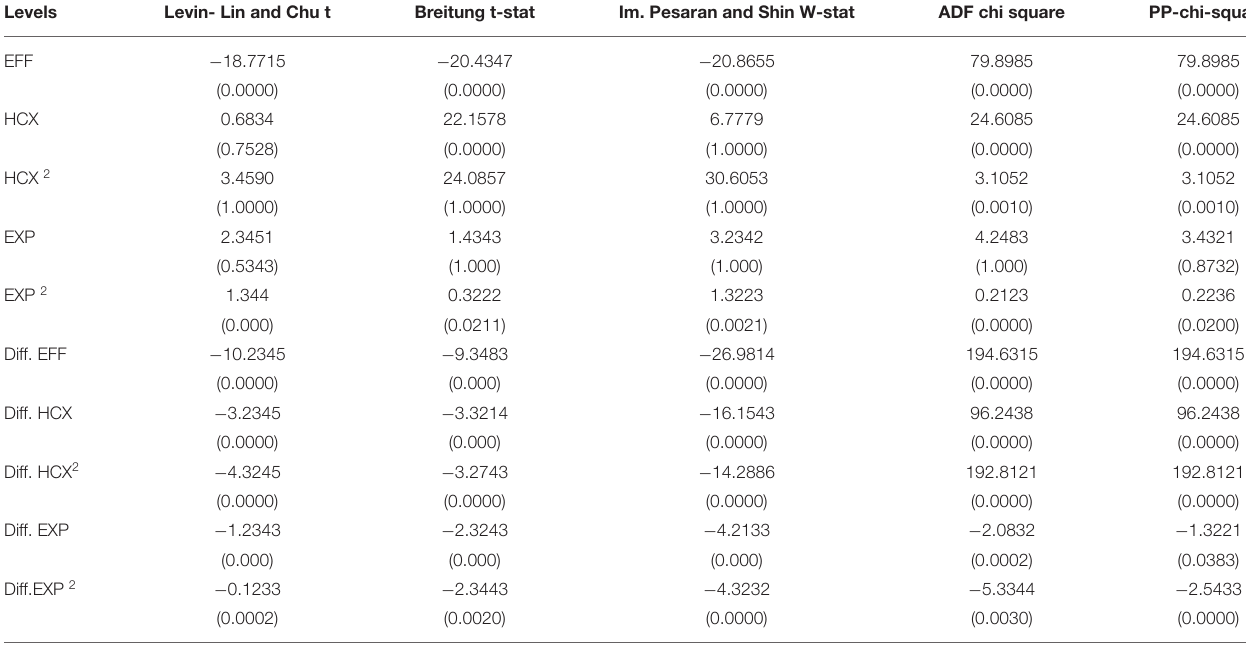
TABLE 5 | Panel unit roots tests.